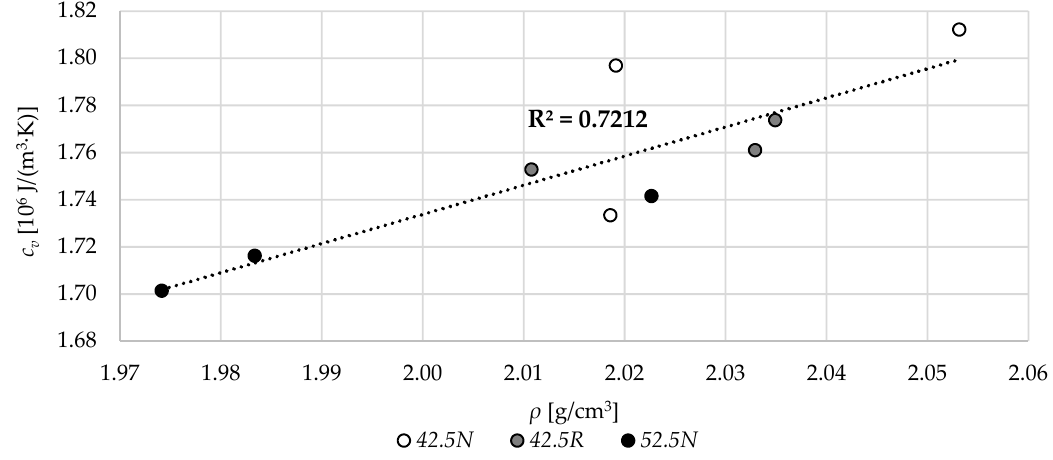
ρ , and volume specific heat, c